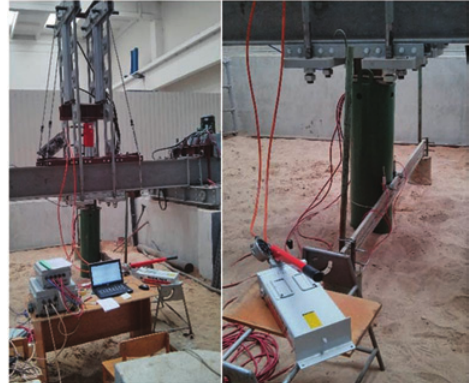
fig. 7. Test of the 1 st model pile